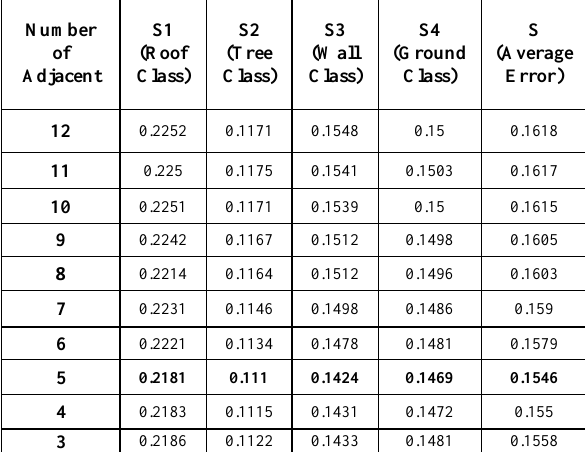
Table 2 . Experimental results for the number of neighbors parameter.